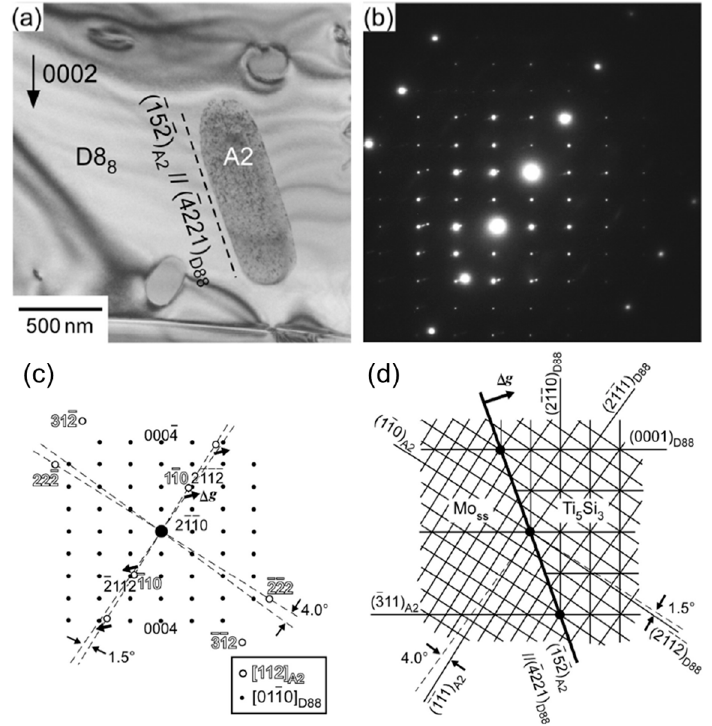
Figure 10. ( a ) A bright-field image; ( b ) corresponding diffraction pattern; ( c ) a key diagram of the diffraction pattern and ( d ) a schematic of the corresponding two-dimensional lattice plane matching for the BCC precipitates and the D8 8 matrix of the Mo–50Ti–14Si–6C–6B (at.%) alloy [53].